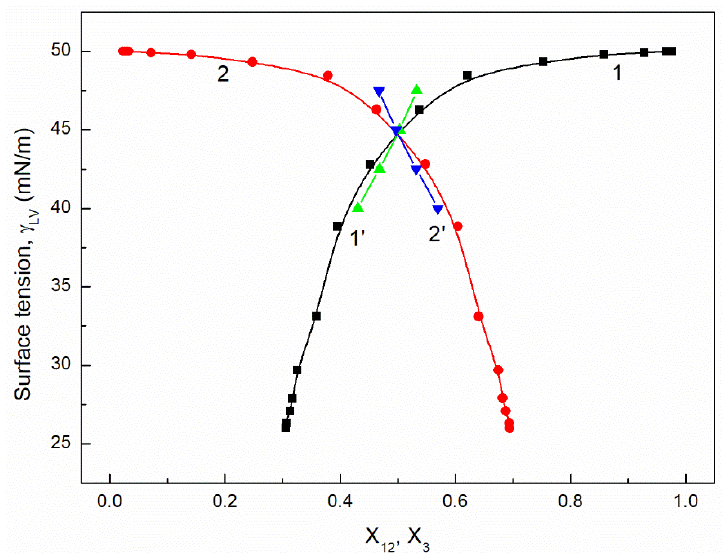
Figure 10. A plot of the surface tension ( γ LV ) of the aqueous solutions of CTAB + TX100 + FC1 mixture at the constant concentration of the binary mixture CTAB + TX100 ( C 12 ) and γ LV = 50 mN/m (m1 (50)) vs. the composition of the ternary mixture in the monolayer ( X 12 and X 3 ) determined based on the contribution of the particular surfactant in the mixture to the reduction of the water surface tension (curves 1 and 2) and calculated from Equation (5) (curves 1’ and 2’). X 12 corresponds to the sum of the CTAB ( X 1 ) and TX100 ( X 2 ) fractions and X 3 corresponds to the FC1 fraction.